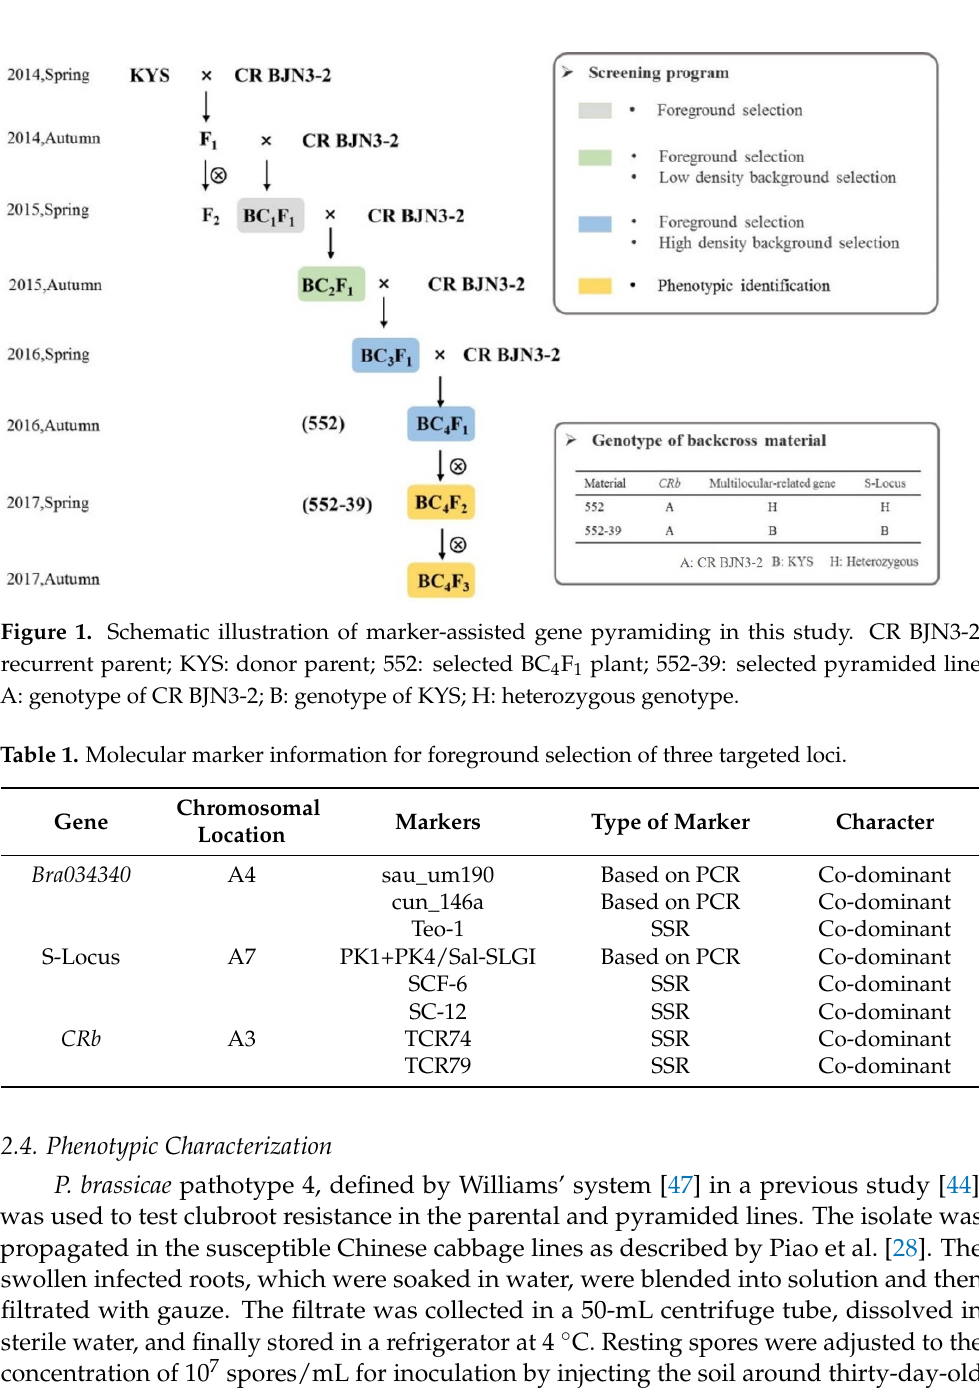
4 of 13 Table 1. Molecular marker information for foreground selection of three targeted loci. Gene